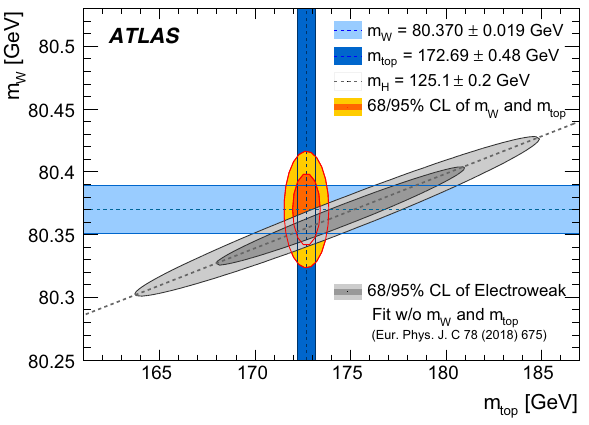
Fig. 11 Comparison of indirect determinations and direct measure- ments of the top quark and W boson masses. The direct ATLAS mea- surements of m W and m top are shown as the horizontal and vertical